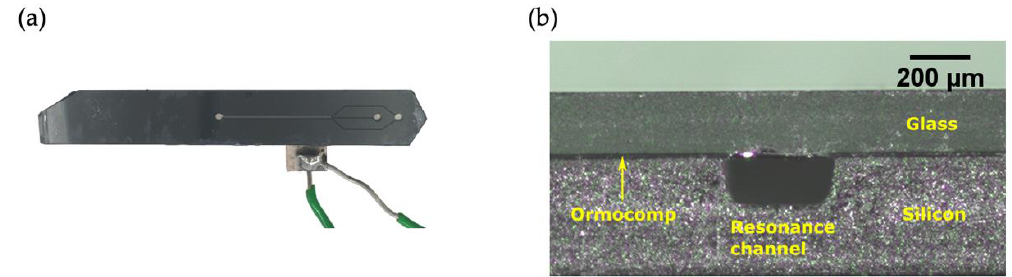
Figure 7. ( a ) The microfluidic chip. ( b ) Cross-section of the resonance channel.